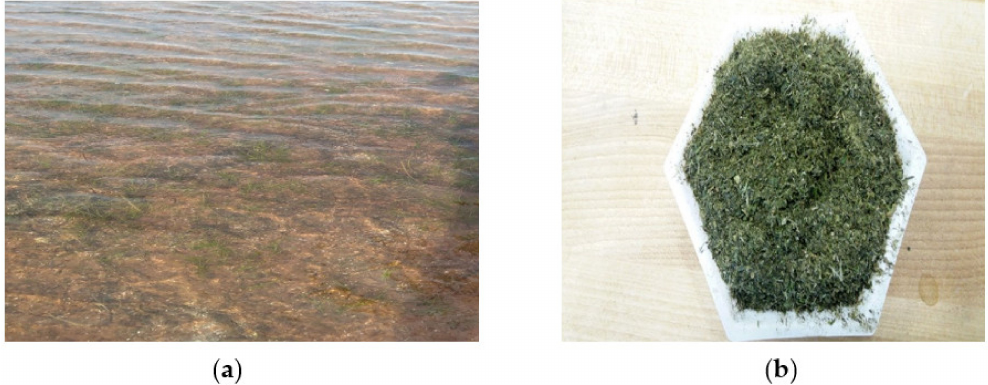
Figure 1. Fresh seaweed on sea surface ( a ) and ground seaweed ( b